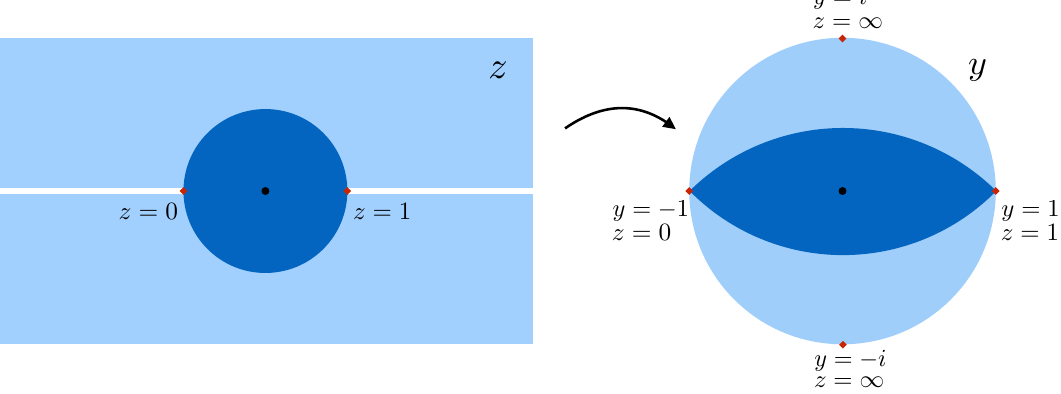
Figure 3 . The transformation (3.3) between the z and y coordinates. z -derivatives evaluated at z = 1 = 2 can reconstruct the values of F (cid:1) ( z ) only in the dark-blue region, while y -derivatives at y = 0 can reconstruct the values everywhere away from the branch